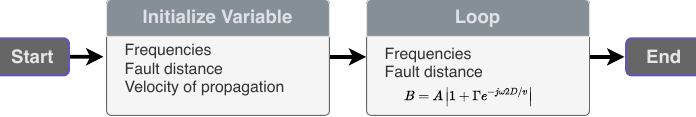
Figure 5. Diagram illustrating simulation for Equation (22).